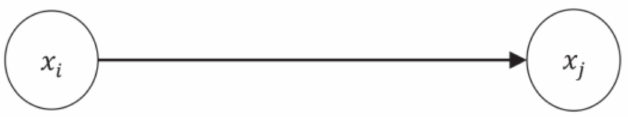
Figure 3. A schematic diagram depicting a general Bayesian network model